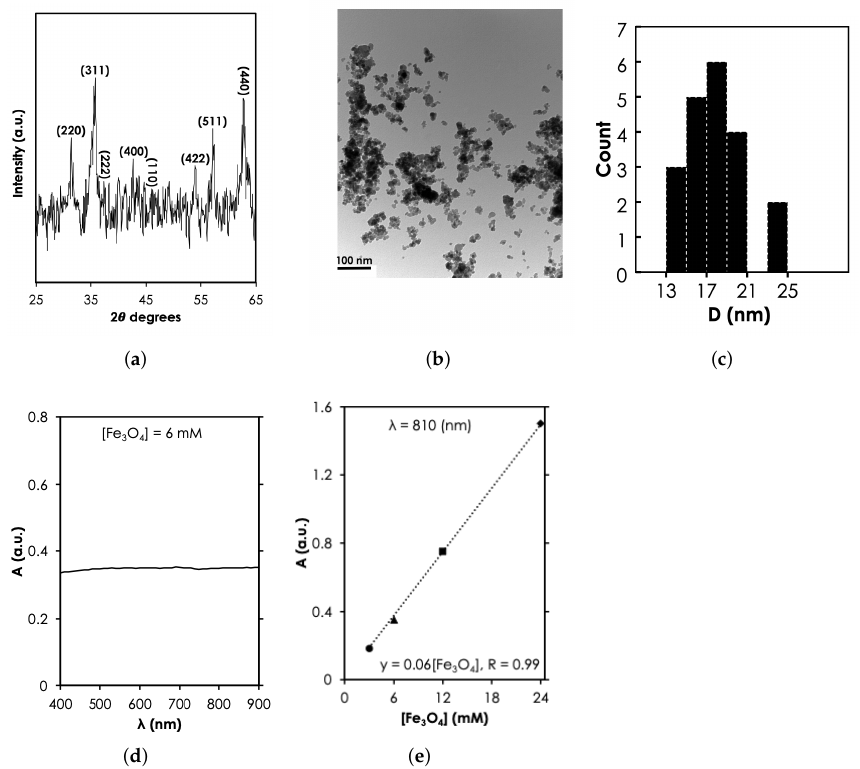
Figure 4. Structural and optical characterization of MNPs results. ( a ) X-ray diffraction spectra of MNPs at a power of 45 kV × 40 mA (Adapted from [32]). ( b ) Transmission electron microscopy of Fe 3 O 4 at magnification of 0.5 mm, scale bar: 100 nm and ( c ) the corresponding nanoparticle count as a function of size, D. UV-vis-NIR absorbance spectra as a function of ( d ) λ for 6 mM of MNPs and ( e ) [Fe 3 O 4 ] at λ = 810